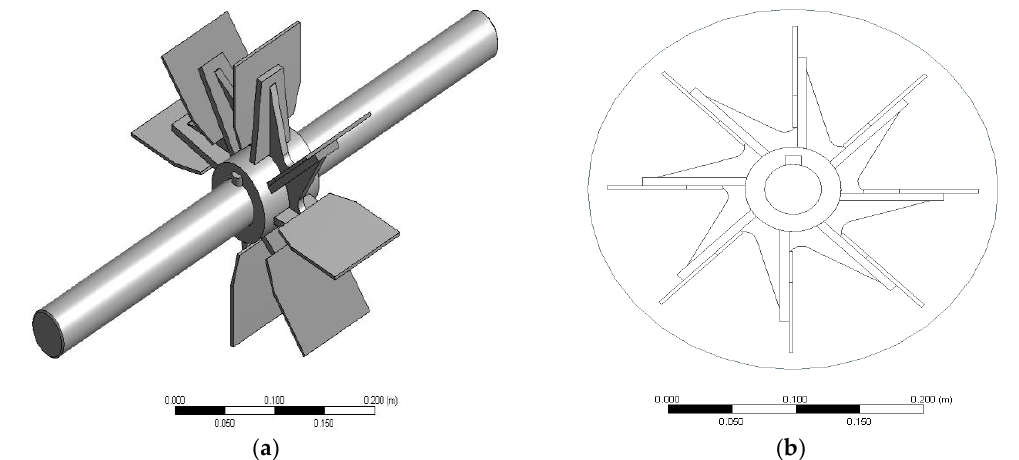
Figure 3. Fan modeled in this work. ( a ) Isometric view; ( b ) cylindrical boundary and domain configured with rotating speed using a moving-reference frame (MRF).